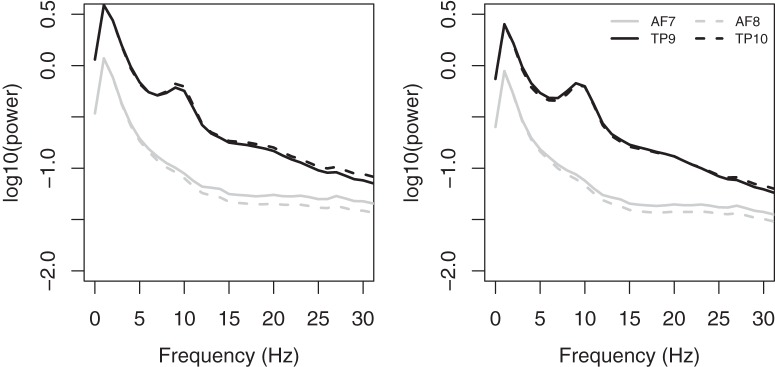
Average power spectra at each channel for CAL (left) and NFB (right) conditions. Frontal and temporoparietal channels are represented by black and gray lines, respectively, and left and right channels in these regions are represented by solid and dashed lines, respectively.